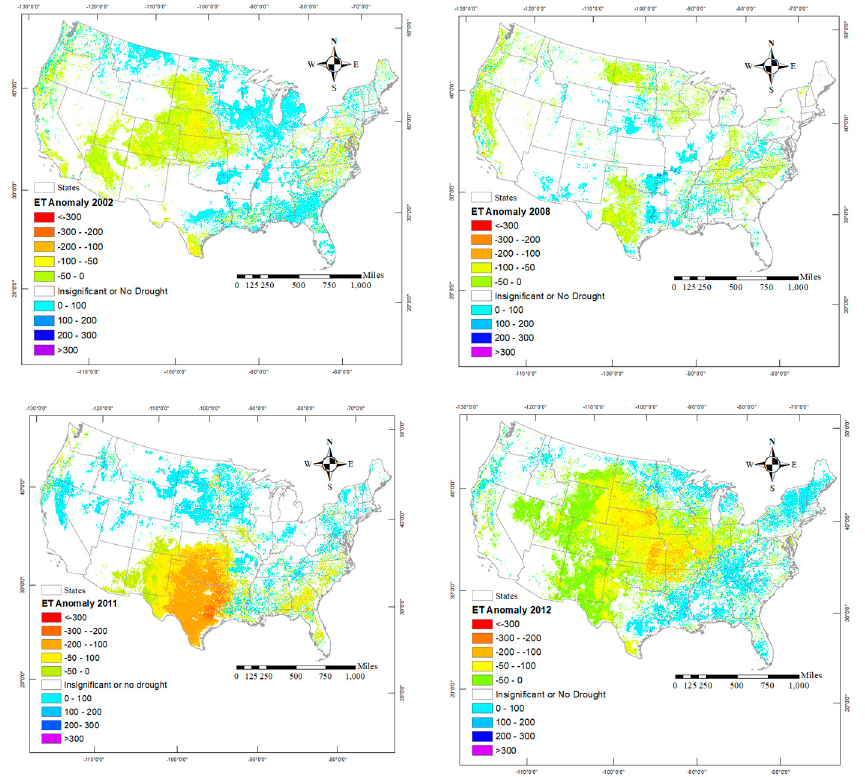
Figure 9. Spatial distribution of ET anomalies (mm) for the 2002, 2008, 2011 and 2012 drought episodes.